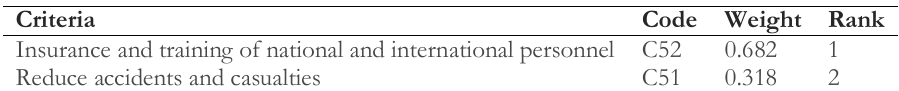
Table 11. Weight and rank of internal marketing criteria.